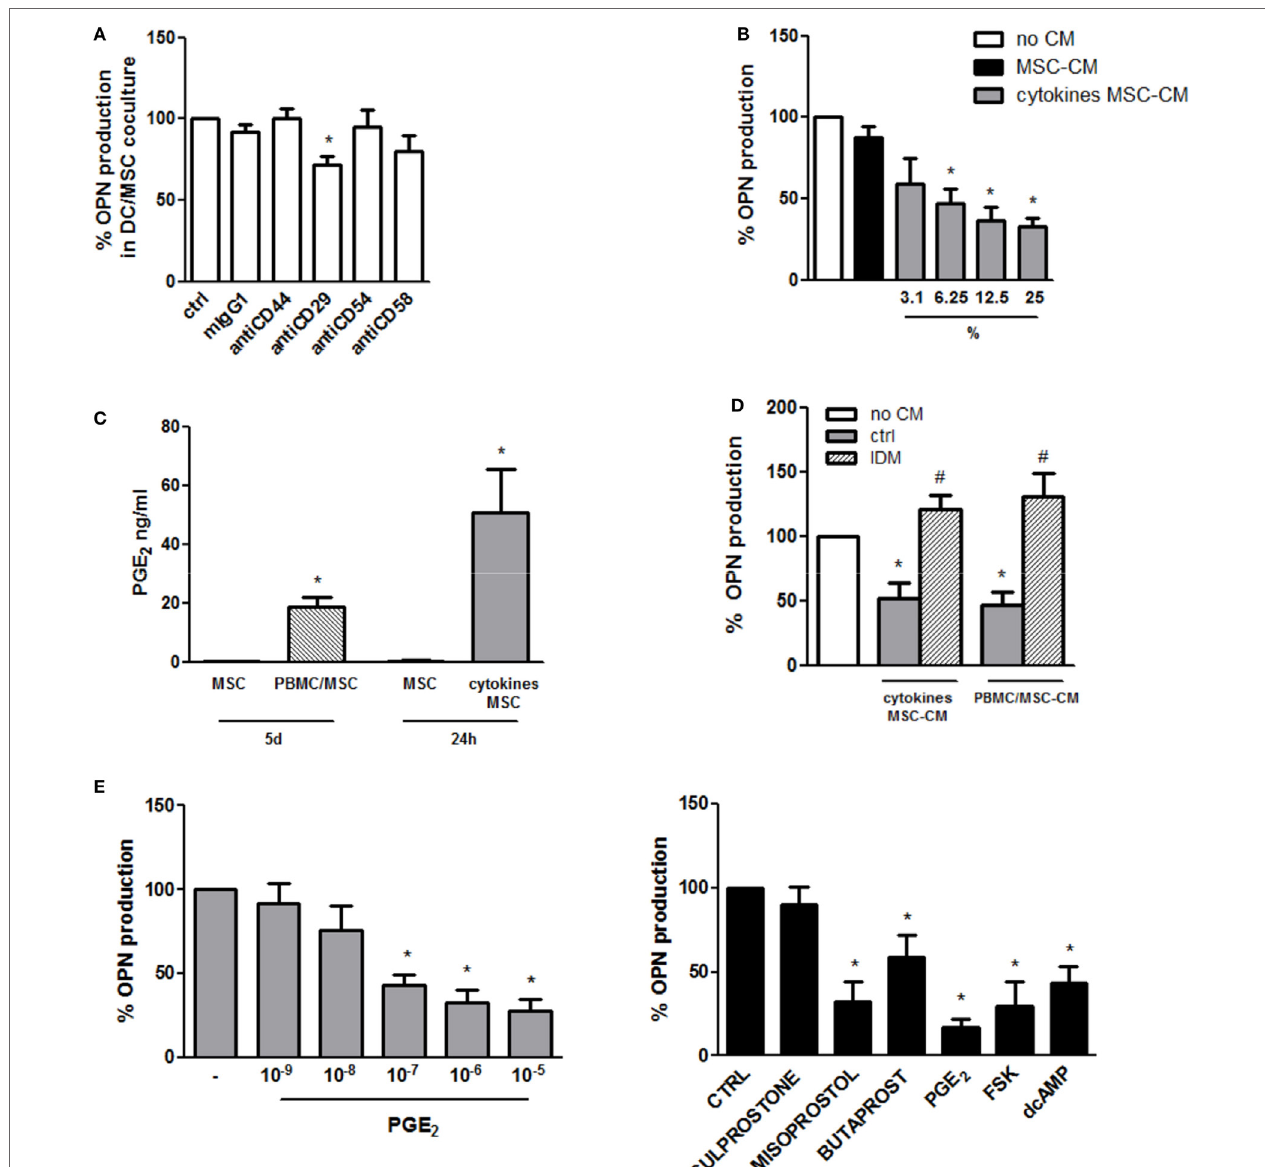
FigUre 2 | Mechanisms involved in the regulation of osteopontin (OPN) production in DC/mesenchymal stromal cells (MSC) cocultures. (a) MSCs were pretreated for 1 h with the specific neutralizing antibodies against CD44, CD29, CD54, and CD58 or the corresponding isotype ctrl (mIgG1) and then cultured with dendritic cells (DCs) (ratio DC/MSC 5:1) for 48 h. Supernatants were collected and tested for OPN production by ELISA. OPN levels are expressed as % of OPN production in DC/MSC alone set as 100% (mean ± SEM of four independent experiments). * p < 0.05 vs. DC/MSC coculture untreated by Student’s t -test. (B) DCs were cultured alone or with the addition of conditioned medium from MSCs unstimulated (25% v/v) or with different concentrations of conditioned medium from MSCs activated for 24 h with proinflammatory cytokines (MSC-CM or cytokines MSC-CM). Supernatants were collected after 24 h and tested for OPN production by ELISA and expressed as % of OPN production by DCs alone set as 100%. * p < 0.05 vs. DCs alone by one-way ANOVA followed by Tukey’s Multiple Comparison Test. (c) PGE 2 levels were measured by ELISA in supernatants from MSCs unstimulated or cocultured for 5 days with PBMCs (PBMC/MSC) or untreated or treated for 24 h with proinflammatory cytokines (cytokines MSC). Results are representative of four and three experiments, respectively. * p < 0.05 vs. MSC unstimulated by Student’s t -test. (D) DCs were cultured alone (no CM) or in the presence of supernatants from MSCs stimulated with proinflammatory cytokines for 24 h (cytokines MSC-CM) or co-cultured with PBMC (ratio PBMC/MSC 5:1) for 5 days (PBMC/MSC-CM). MSC stimulation was performed with or without indomethacin (IDM). After 24 h, DC supernatants were collected and tested for OPN production by ELISA. Results are expressed as % of OPN production by DCs alone set as 100% (mean ± SEM of six independent experiments). * p < 0.05 vs. DCs alone (no CM); # p < 0.05 vs. MSC-CM without IDM (ctrl) by one-way ANOVA followed by Tukey’s Multiple Comparison Test. (e) DCs were stimulated with different concentrations of PGE 2 . Supernatants were harvested 24 h later and subjected to OPN ELISA (left panel) (mean ± SEM of six independent experiments). DCs were stimulated with Sulprostone (EP1/3 agonist), Butaprost (EP2 agonist), Misoprostol (EP2/3/4 agonist), PGE 2 , Forskolin (FSK), and dcAMP. After 24 h, supernatants were collected and tested for OPN by ELISA (right panel) (mean ± SEM of four independent experiments). Results are expressed as % of OPN production by DCs alone set as 100%; * p < 0.05 vs. DCs alone by one-way ANOVA followed by Dunnett’s Multiple Comparison